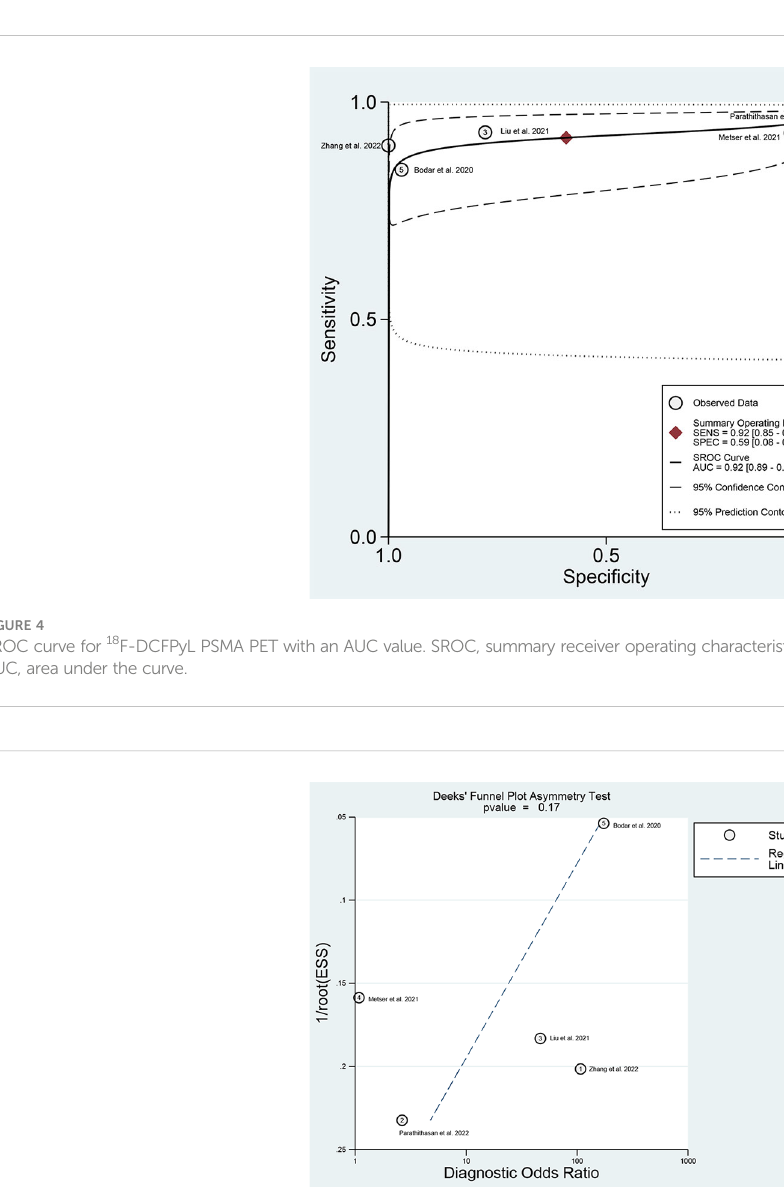
FIGURE 5 Deeks ’ test.